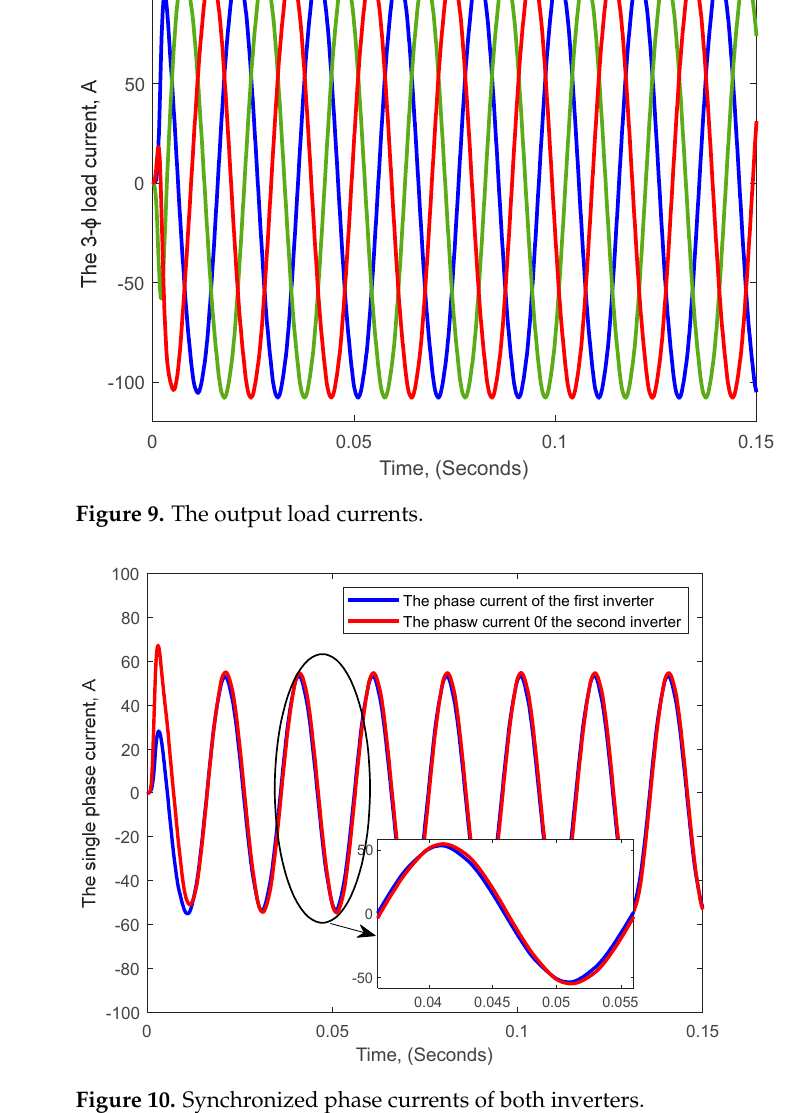
Figure 10. Synchronized phase currents of both inverters.